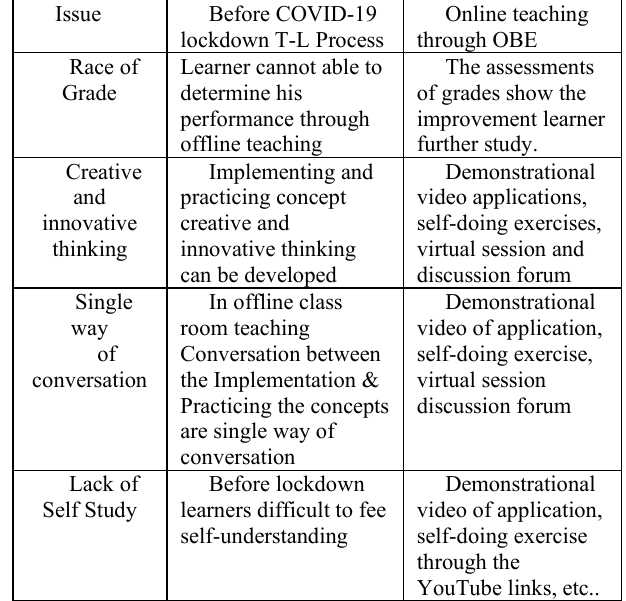
Table 3. Online teaching pedagogy before and after lockdown [48].